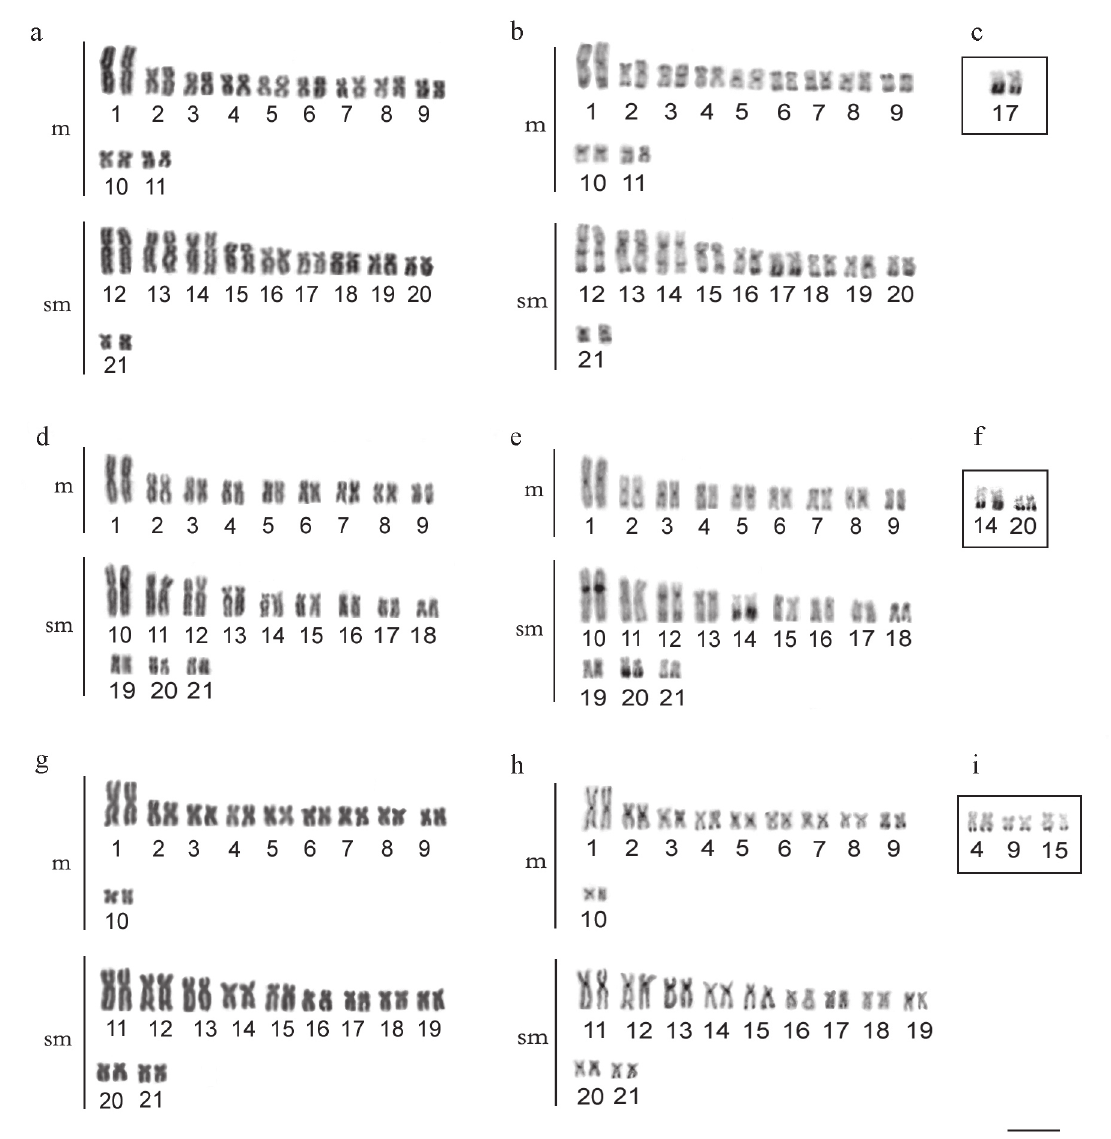
Fig. 1. Hoplias malabaricus karyotypes (karyomorph A) with conventional Giemsa staining ( a , d , g ) and C-banding ( b , e , h ) of the populations from the basins of the São Francisco ( a , b ), Araguaia ( d , e ) and Xingu ( g , h ) Rivers. Boxes display chromosomes with Ag-NORs in the populations from the São Francisco ( c ), Araguaia ( f ) and Xingu ( i ) Rivers. Scale bar = 5 μ